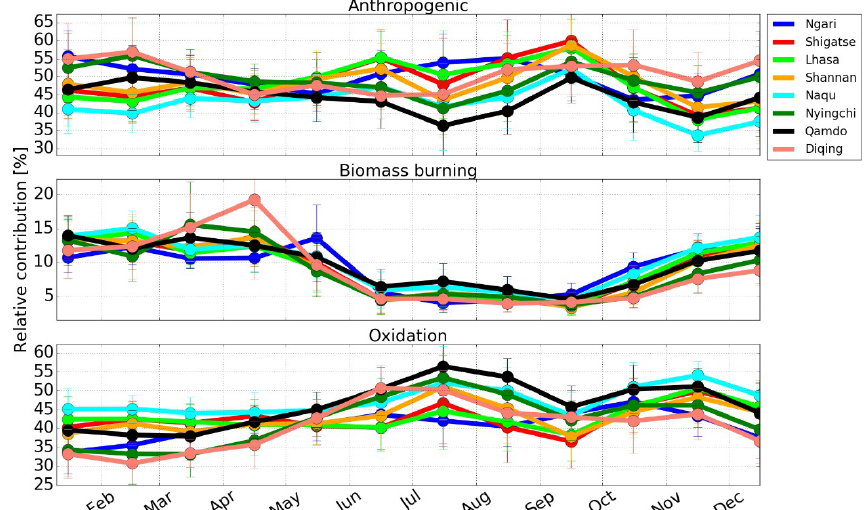
Figure 7. Monthly mean contributions of anthropogenic, biomass burning (BB) and oxidation transport to CO over the HTP. The vertical error bar represents 1 σ standard variation within that month. See Table 2 for a description of each